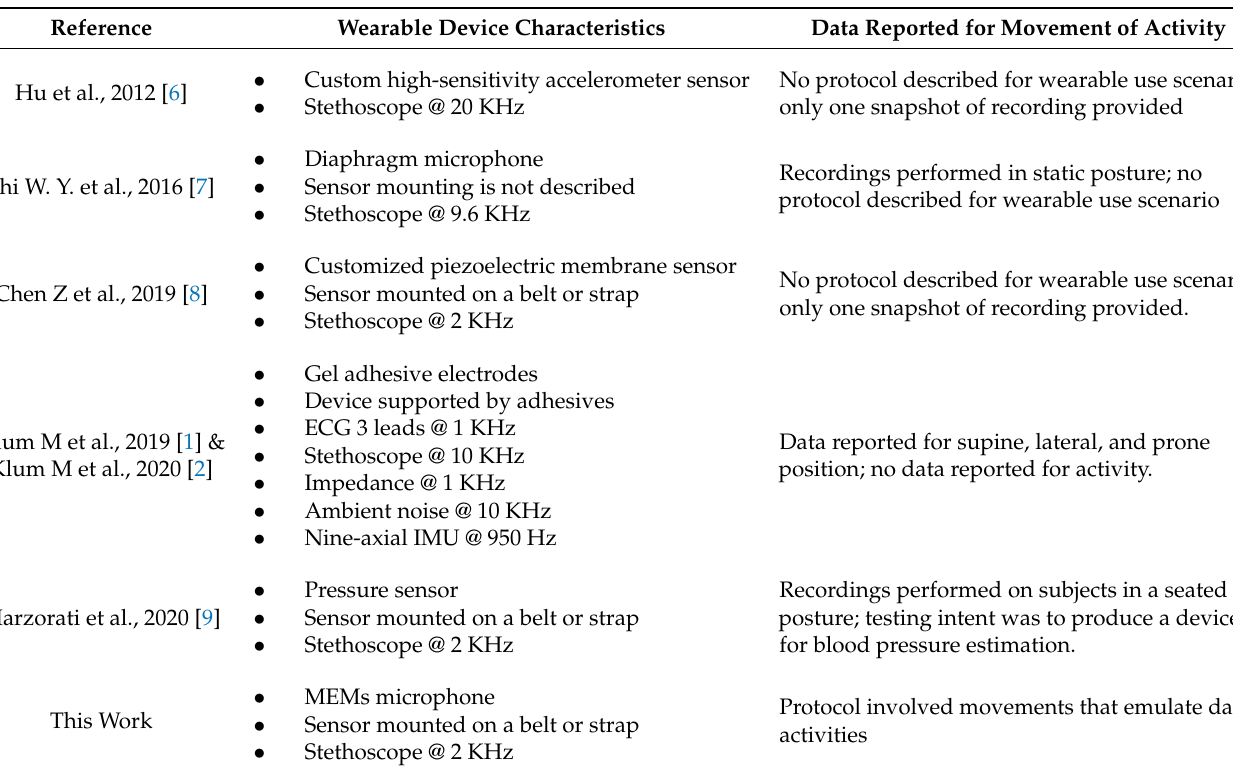
Table 1. Previous research works in the literature related to the current